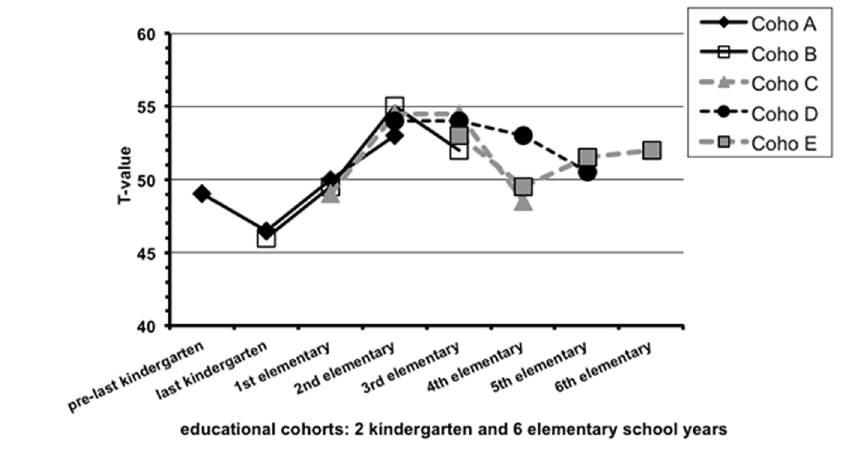
Figure 4. Cross-sequential results on dysthymic mood (DM) in the Luxembourg sample.